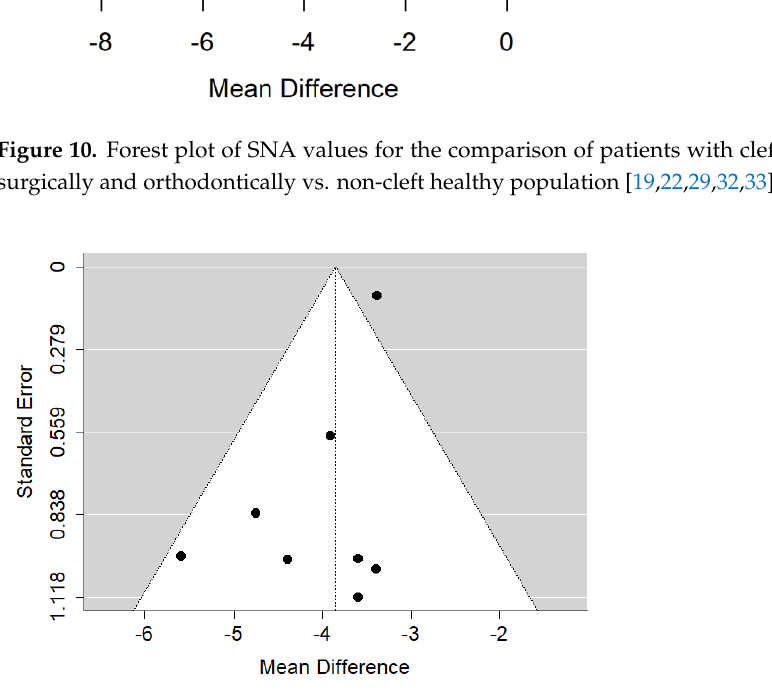
Figure 11. Funnel plot of SNA values for the comparison of patients with cleft palate only treated surgically and orthodontically vs. non-cleft healthy population [19,22,29,32,33]. ANB